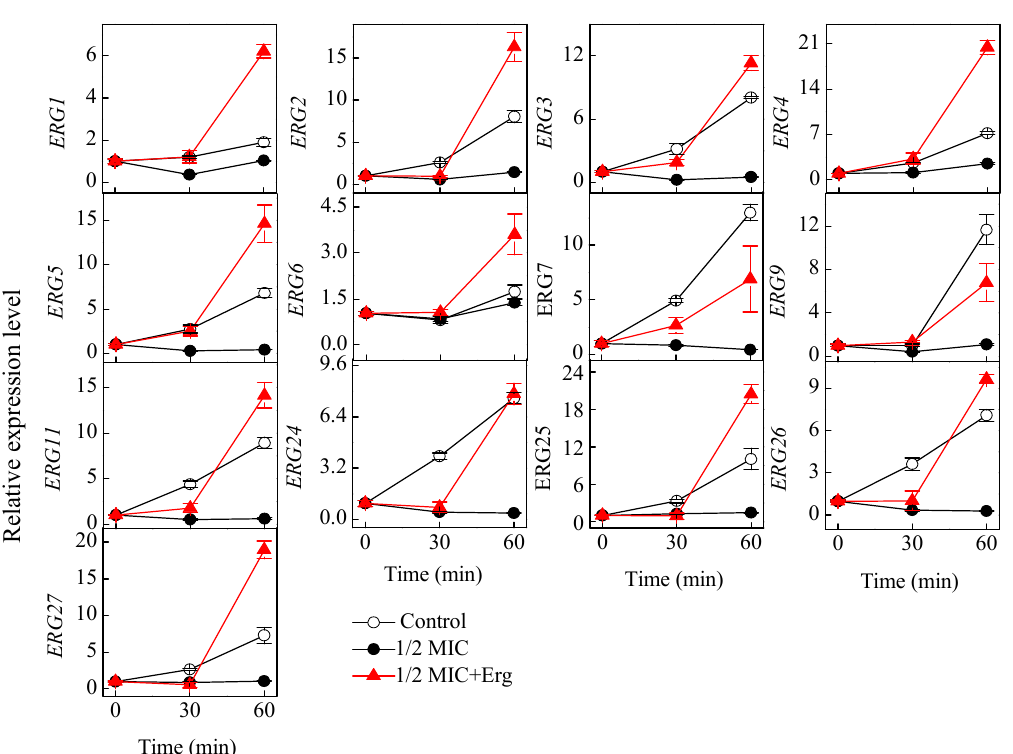
Figure 4. Changes in the expression of ergosterol biosynthesis genes of P. digitatum mycelia treated by control, 1/2 MIC citronellal treated samples, and 1/2 MIC citronellal + Erg treated samples for 0, 30, and 60 min. The data presented are the means of pooled data. Error bars indicate the SDs of the means (n = 3).